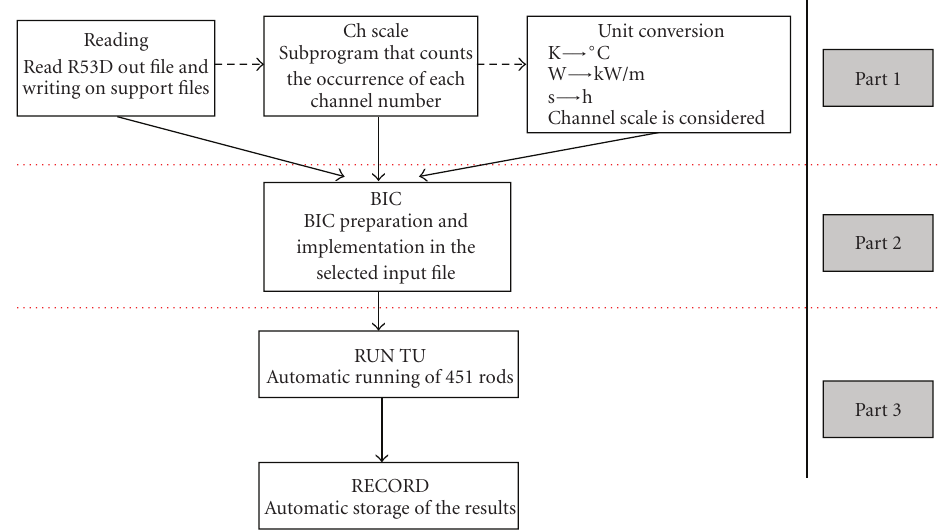
Figure 8: Outline of program blocks.